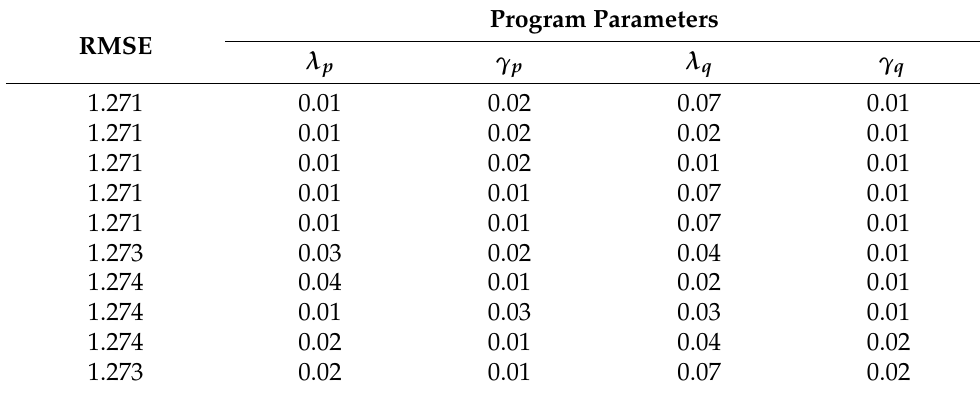
Table 7. Best programs obtained from 10 evolution runs of 50 generations using the CoMoDa dataset.